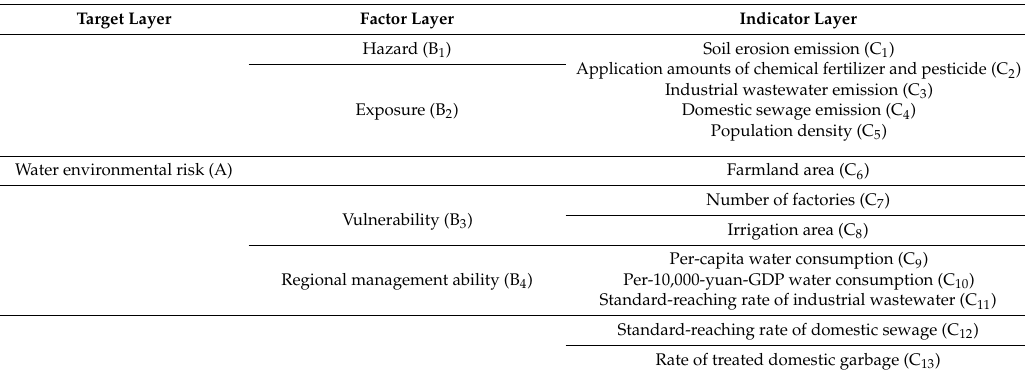
Table 2. The layers of the evaluation indicator